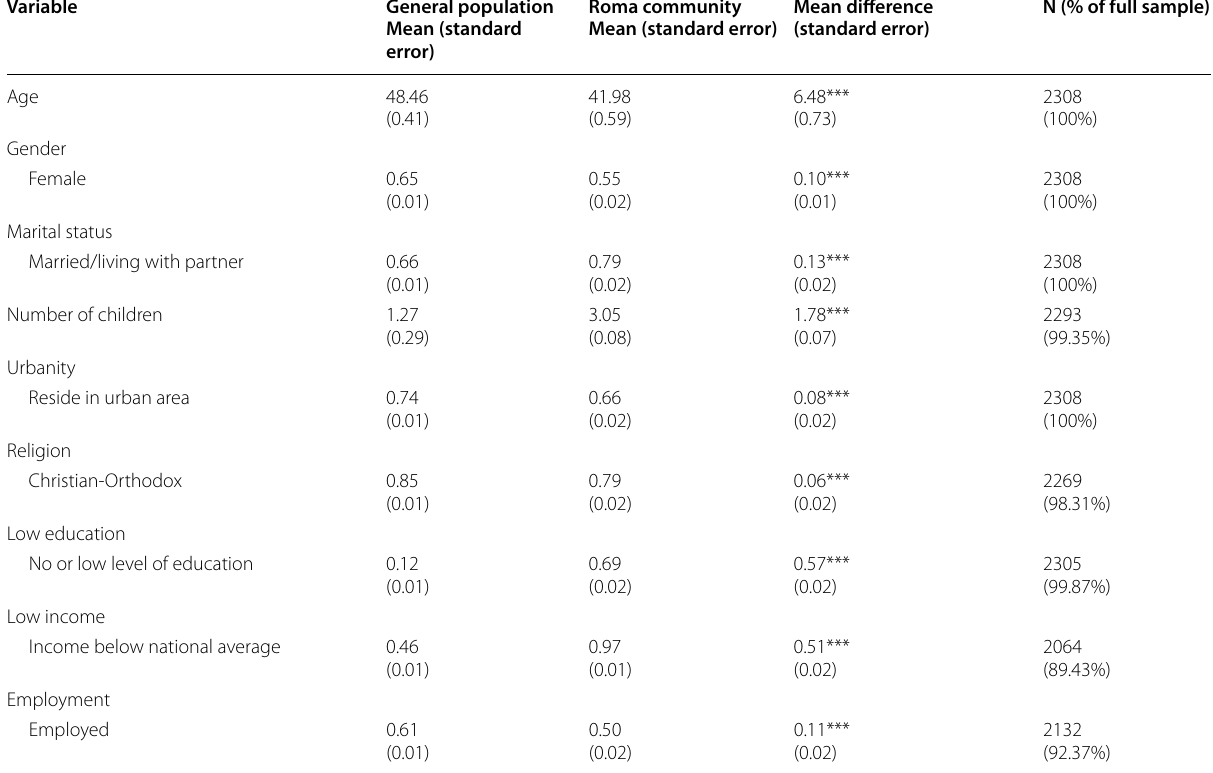
Standard errors in